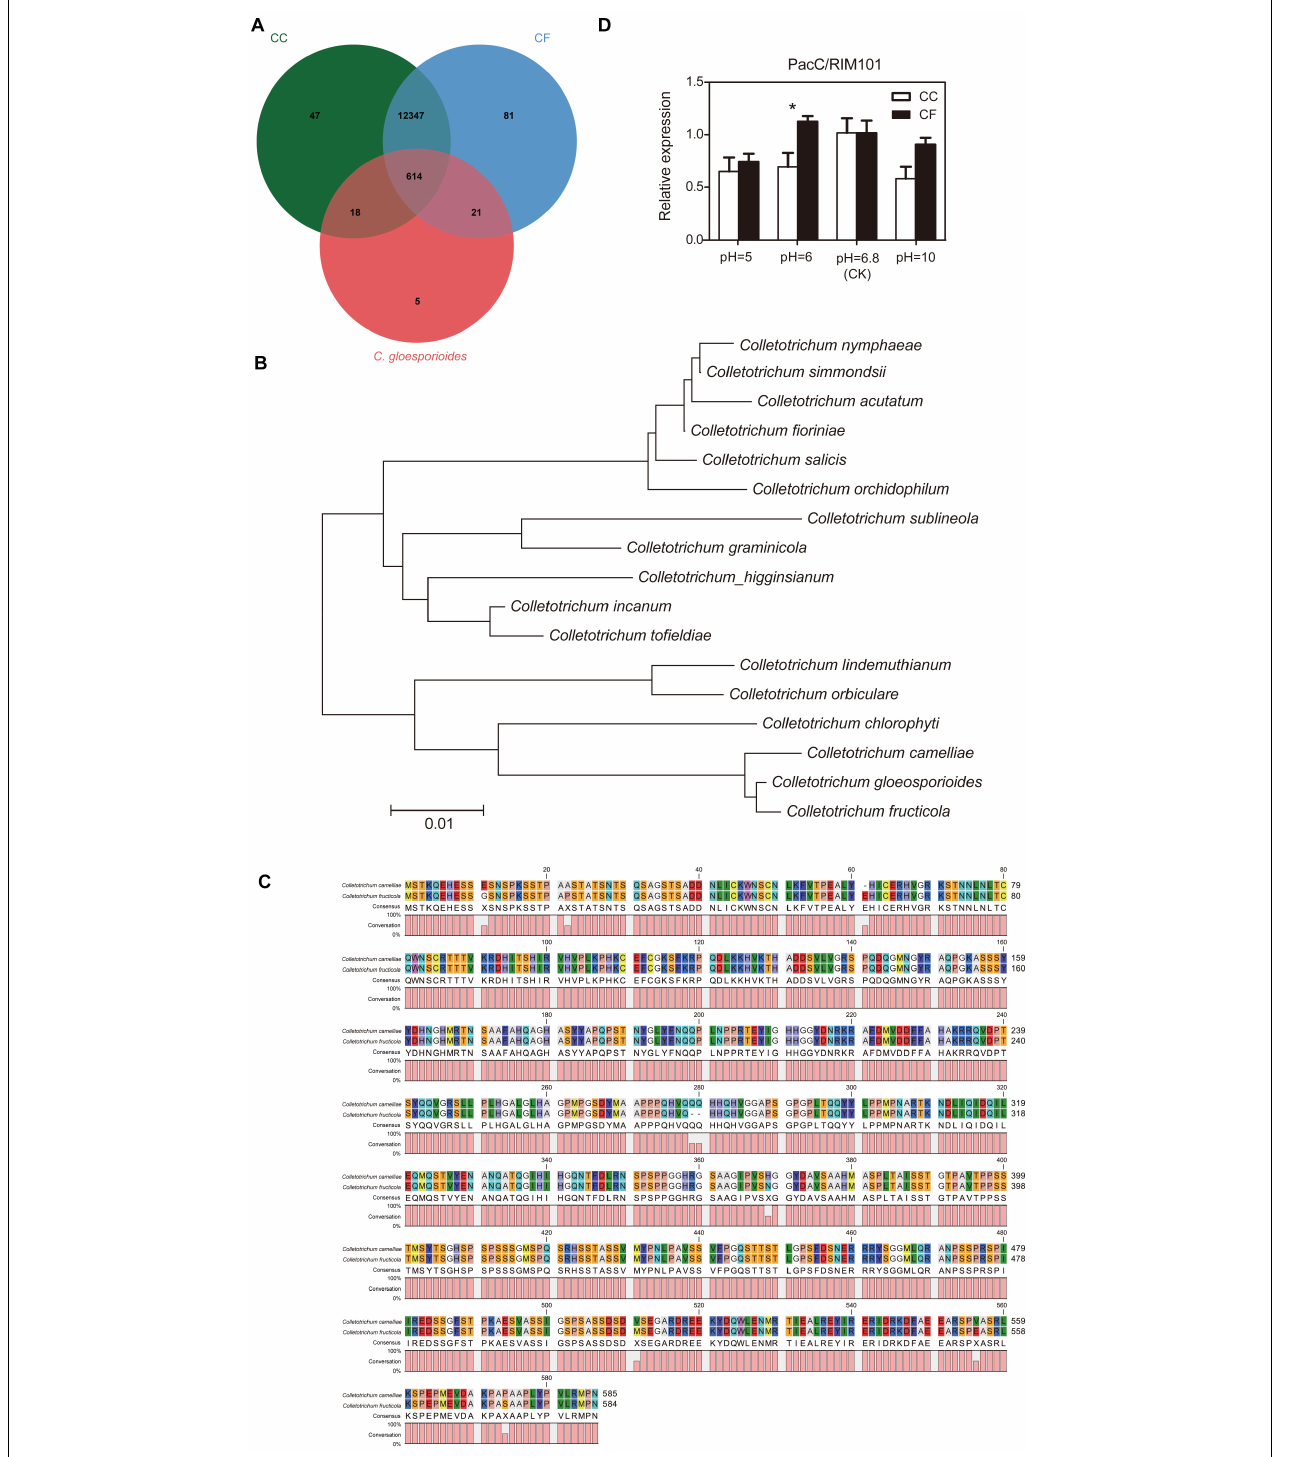
FIGURE 5 | Analysis of PacC/RIM101 expression in C. camelliae and C. fructicola . (A) Venn diagram of the genome summarizing the numbers of sequences among the three species. CC, C. camelliae . CF, C. fructicola. (B) Phylogenetic tree relating PacC/RIM101 orthologs. This tree was constructed with MEGA v 5.0 using the neighbor-joining method. (C) Sequence alignment of PacC/RIM101 genes using Clustal Omega (https://www.ebi.ac.uk/Tools/msa/clustalo/) and CLC Sequence Viewer 8. (D) Quantitative real-time polymerase chain reaction (qRT-PCR) analysis showing the relative expression of the PacC/RIM101 gene presented as the average and SEM. CC was represented by the LS_19 strain; CF was represented by the SX_6 strain.